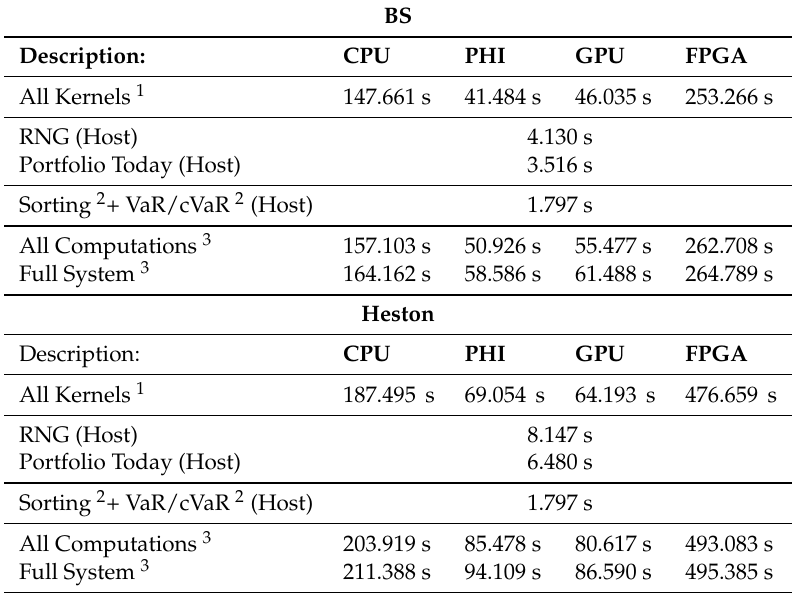
Table 7. Full runtime breakdown (s) with external RN sequences—( pathsMCext/pathsMCint ) = (32 k /32 k